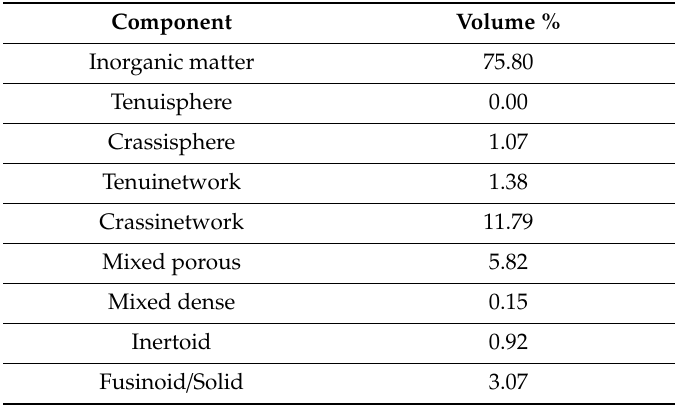
Table 5. Percentage composition of bottom ash resulting from the combustion of coal.